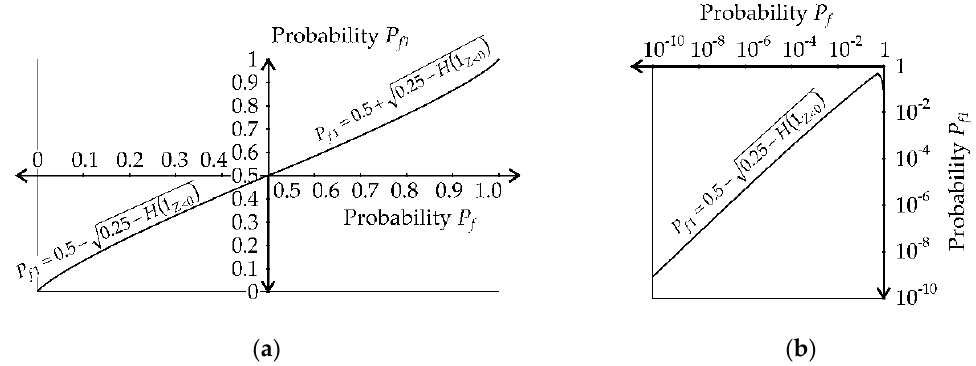
Figure 5. Dependence between P f and P f 1 : ( a ) graph for P f [0, 1]; ( b ) graph for P f [1 × 10 −1 0 , 1].